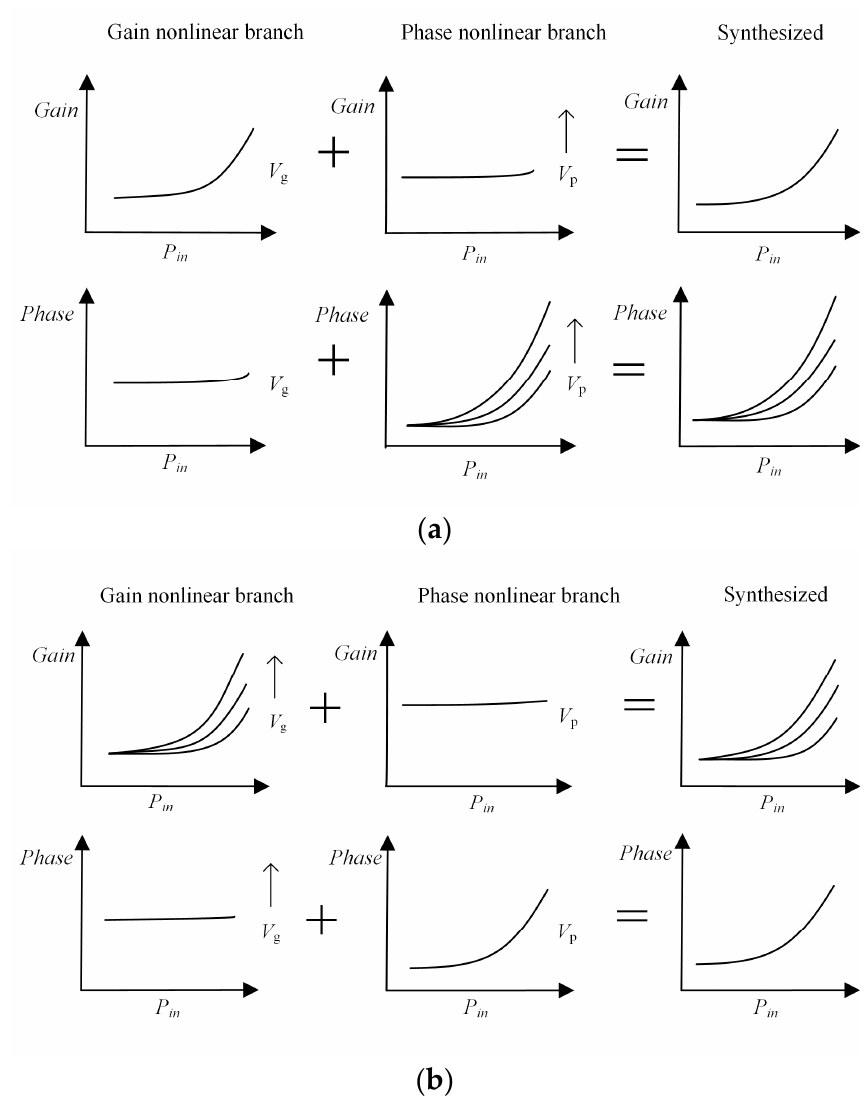
Figure 4. Schematic diagram of ( a ) gain expansion and ( b ) phase expansion independently tuning.